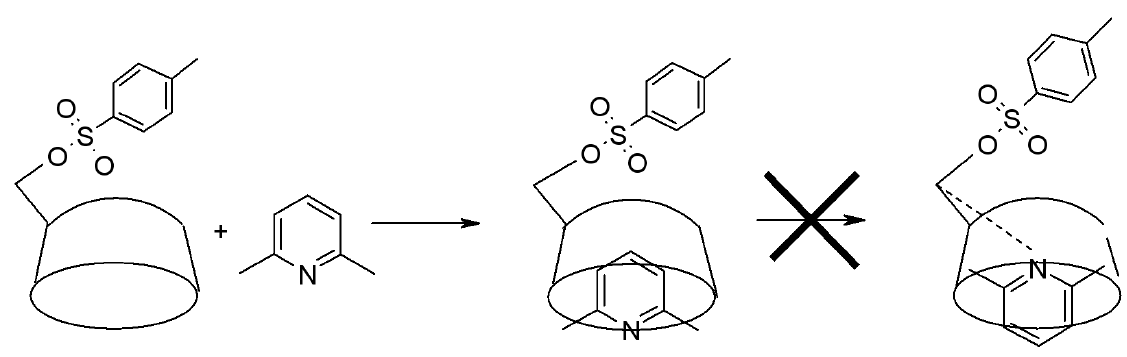
Table 1 Traditional and microwave assisted synthesis of mono[6–(lutidinyl)–6–deoxy]– β –